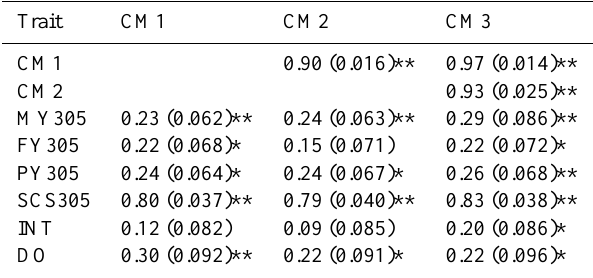
Table 4. Estimates of additive genetic correlations between CM traits, SCS, and milk production, including their standard errors (in